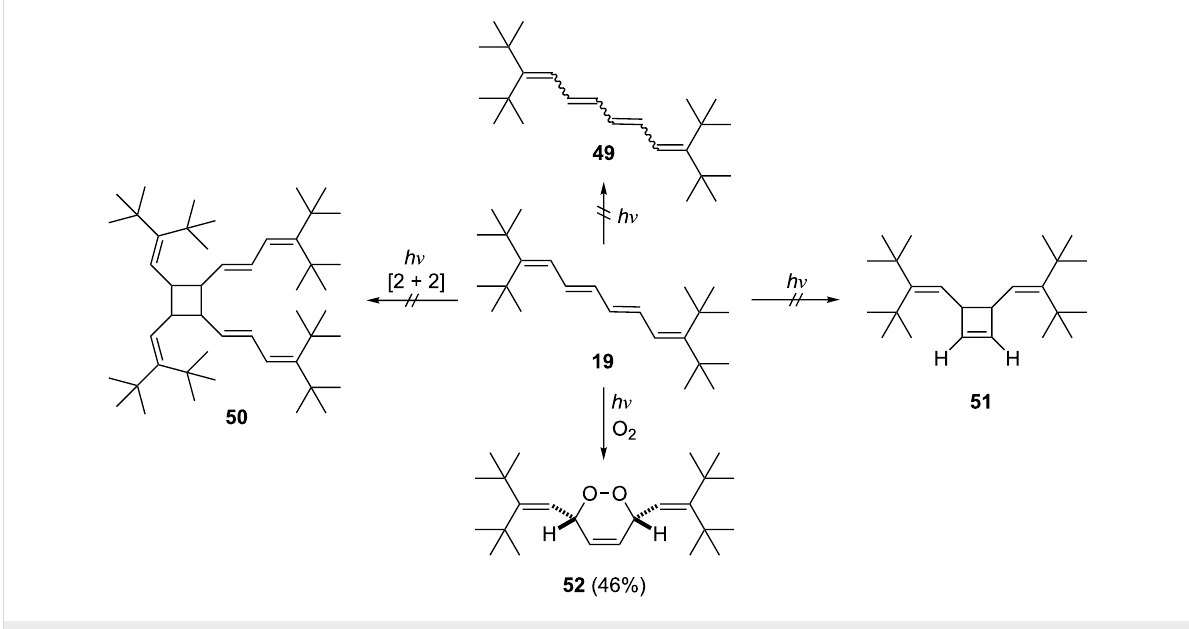
Scheme 13: Photochemical experiments with tetraene 19 .